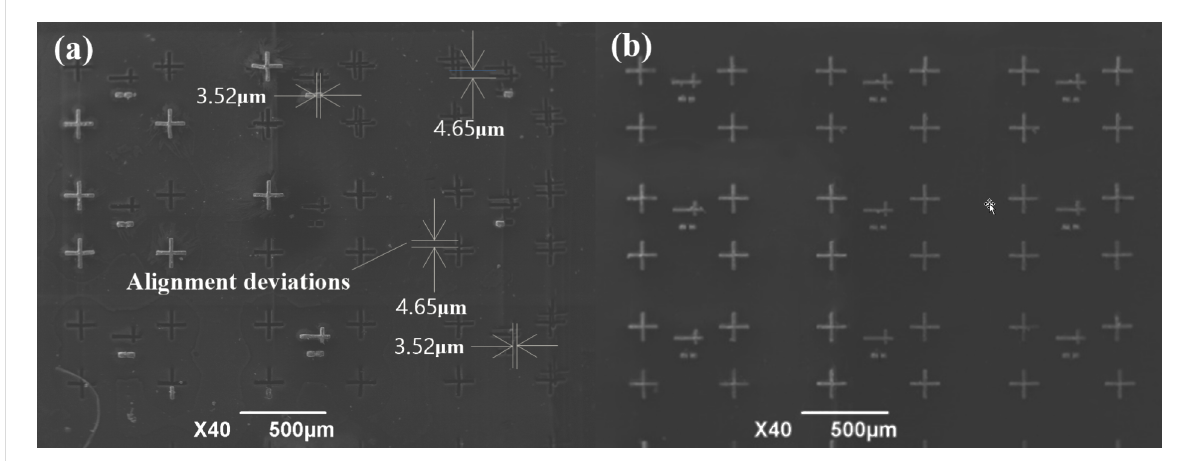
Figure 6: OTFT electrodes alignment. (a) Electrode alignment of the 20 wt % composite template prepared via wet blending. (b) Electrode alignment of the 83.8 wt % composite template prepared via dry blending.